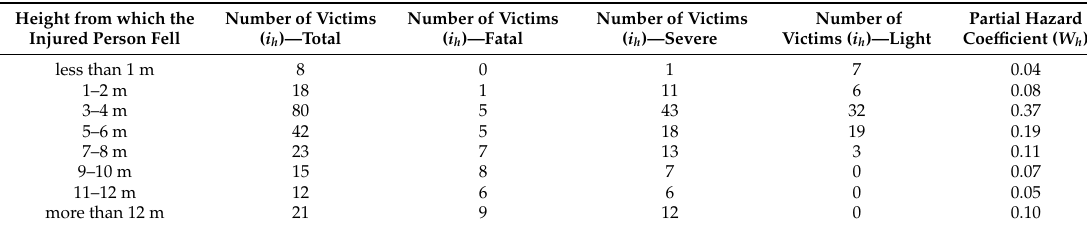
Table 3. Height from which the accident